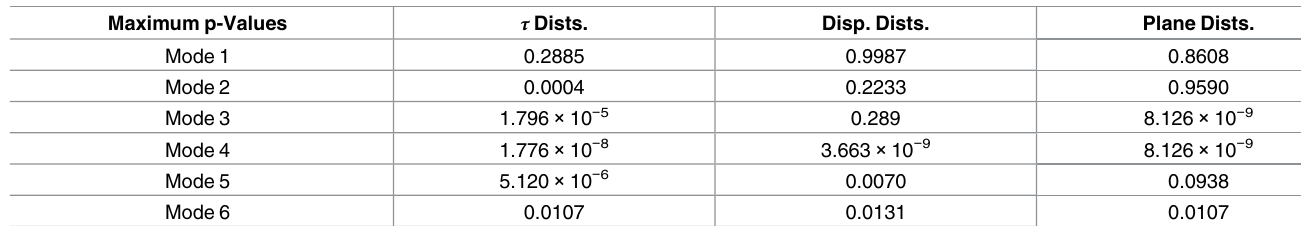
modes as is produced by the standard connectome, and thus the distributions of τ and projec- tion values may be directly compared. We wish to determine if the results which we obtain from the altered connectome are statistically different from those which we obtain from the standard connectome. For each of the 5 altered connectomes, we compare the altered and standard τ /projection distributions using the two-sample Kolmogorov-Smirnov test, with the null hypothesis that they are from the same distribution (computed in MATLAB using the built-in function kstest2.m ). The maximum p-values for each distribution from the set of tests is shown in Table 4. At a significance level of p = 0.05, we can conclude that altering the specific connectivity alters the following results: the τ values of Modes 2, 3, 4, 5 and 6; the